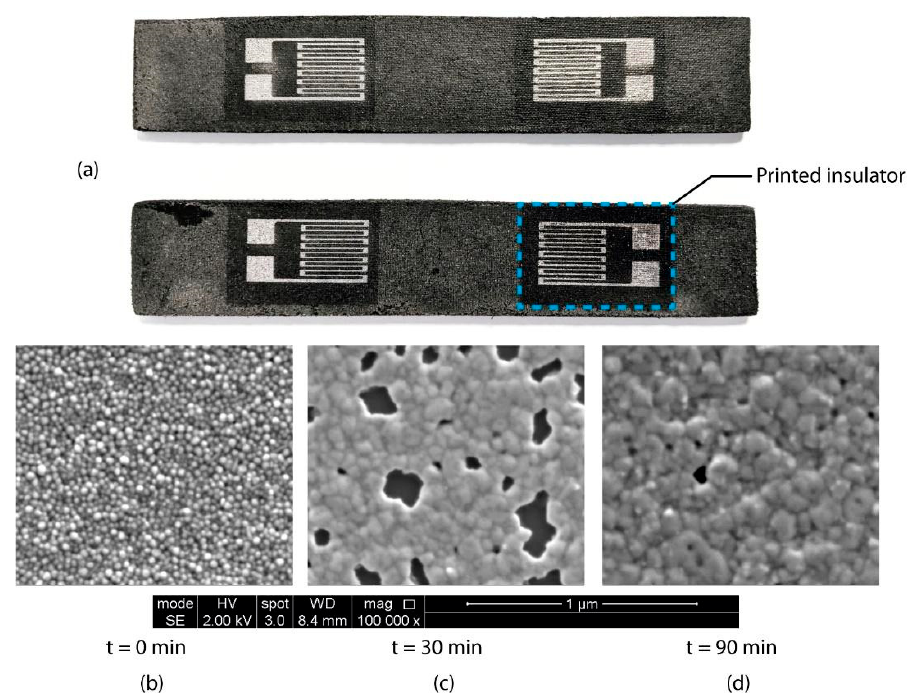
Figure 5. ( a ) Snapshot of the strain gauges printed on the CFRP sample. Results of SEM analysis at different stages of sintering of the silver nanoparticle ink; ( b ) represents the printed silver NPs ink without any heat treatment; ( c ) represents the surface of the pattern after 30 min of sintering, indicating necking and a porous surface; ( d ) represents the final sintered pattern after 90 min, showing a significant reduction in porosity.